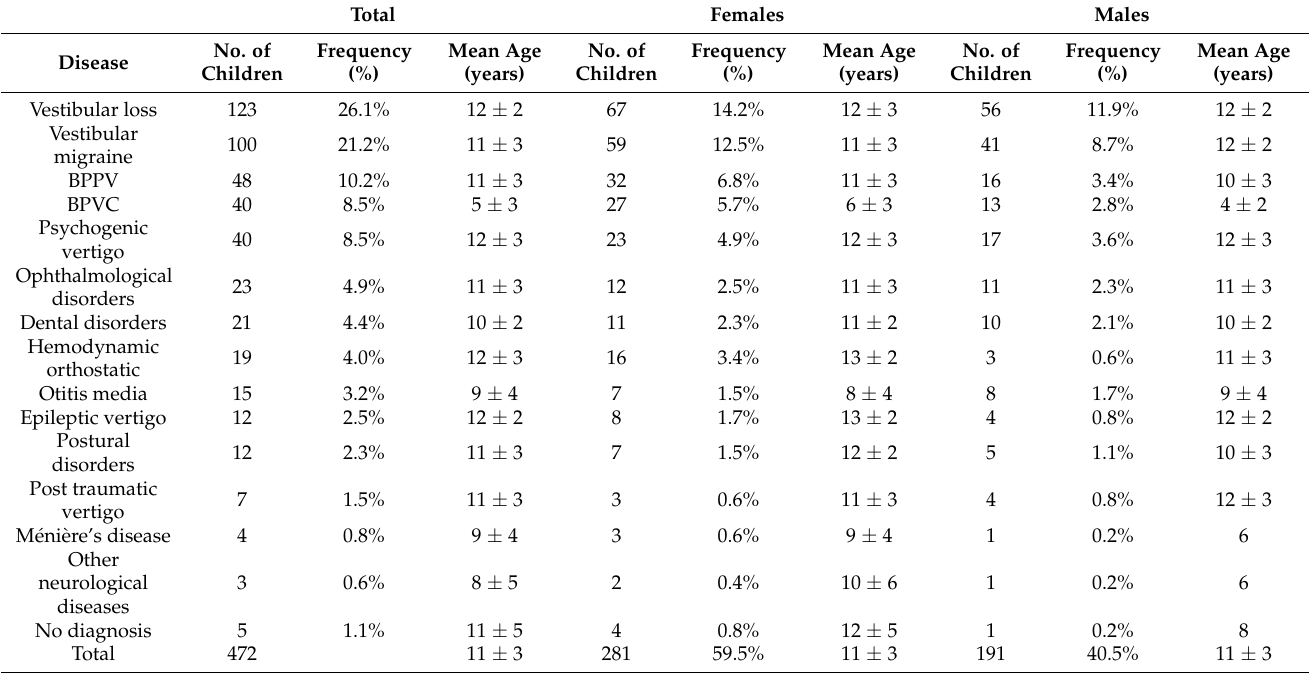
Table 1. Vertigo in children and adolescents: distribution of causes in the entire group ( n = 472) and by gender. Total Females Males